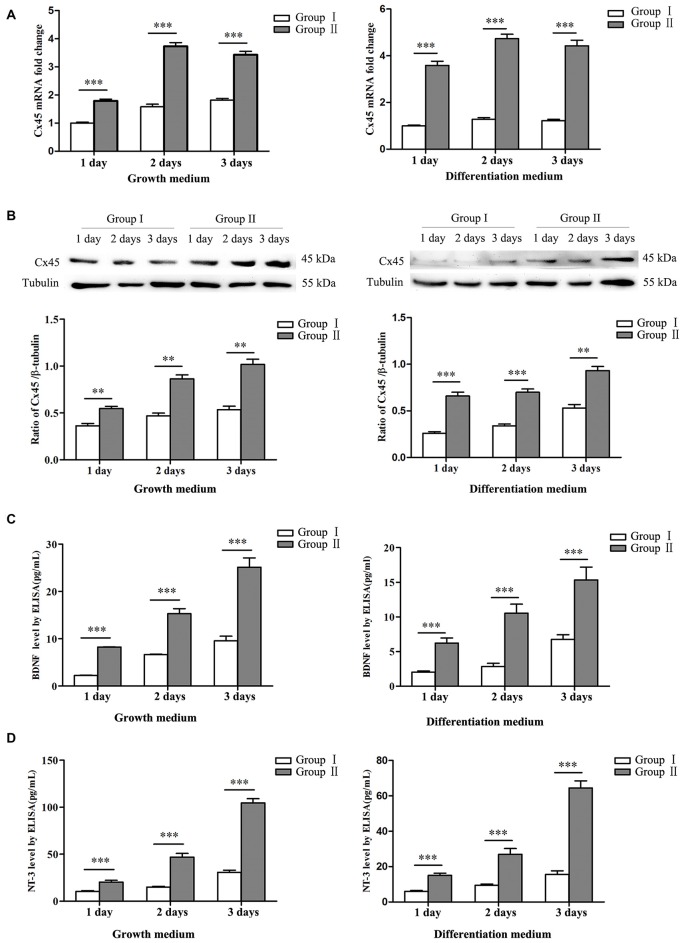
Expression of connexin 45 (Cx45), brain derived neurotrophic factor (BDNF) and neurotrophin 3 (NT-3). (A) Significantly higher mRNA levels of Cx45 in NSCs/NPCs in the Group II were detected, both in growth medium (left) and differentiation medium (right). (B) Significantly higher protein levels of Cx45 in NSCs/NPCs in the Group II were detected, both in growth medium (left) and differentiation medium (right). (C) Significantly higher levels of BDNF was secreted from NSCs/NPCs in the Group II, detected by ELISA assay, both in growth medium (left) and differentiation medium (right). (D) Significantly higher levels of NT-3 was secreted from NSCs/NPCs in the Group II, detected by ELISA assay, both in growth medium (left) and differentiation medium (right). The data were obtained from three independent experiments and three replicates for every experiment. The values are mean ± SD and analyzed via Student’s T test. **P < 0.01, ***P < 0.001.